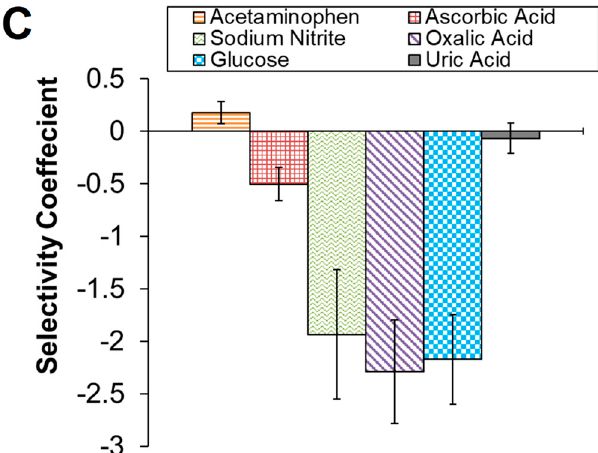
Figure 3. ( A ) Typical amperometric I-t response and calibration curve (inset) during successive 100 µ M injections of uric acid at a Pt-Ir wire electrode modified with UOx-doped HMTES xerogel, undoped HMTES xerogel, polyluminol-polyaniline (PL-A), and polyurethane layer (100% HPU), and epoxy cap; ( B ) Typical amperometric I-t response and ( C ) calculated selectivity coe ffi cients during successive injections of common interferent species (40 µ M) and uric acid (100 µ M and / or 300 µ M) at a Pt-Ir wire electrode modified as in (A); Solution: 60.0 mM PBS, pH = 7.4, µ = 155 mM. Note: Error bars represent standard error (n ≥